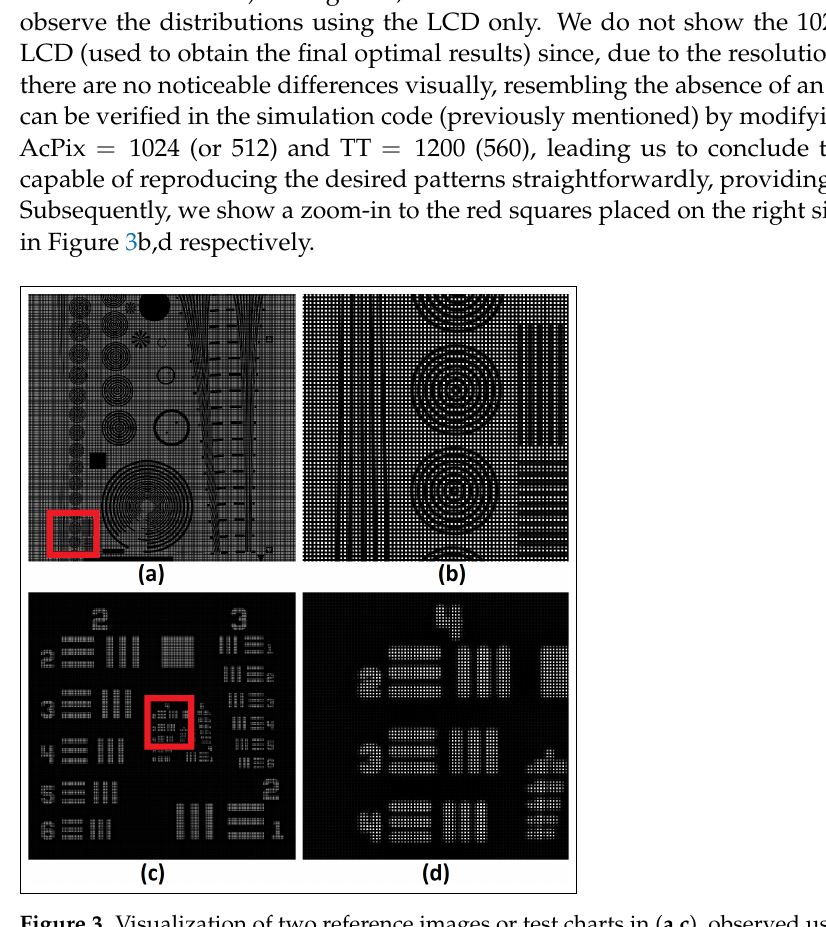
Figure 3. Visualization of two reference images or test charts in ( a , c ), observed using the 512 × 512- pixels simulated LCD. We perform a zoom-in to the red square in each image and show it in the right panels in ( b , d ),